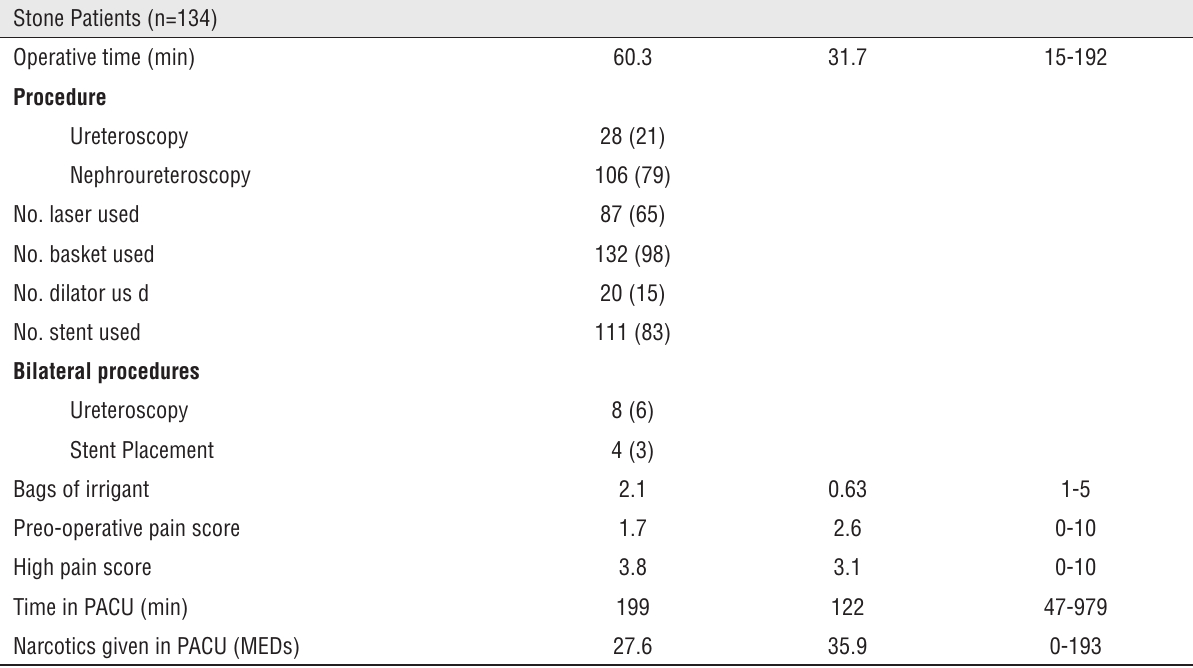
Table 2 - Operative procedures, post-Operative Exerience and pain. Stone Patients